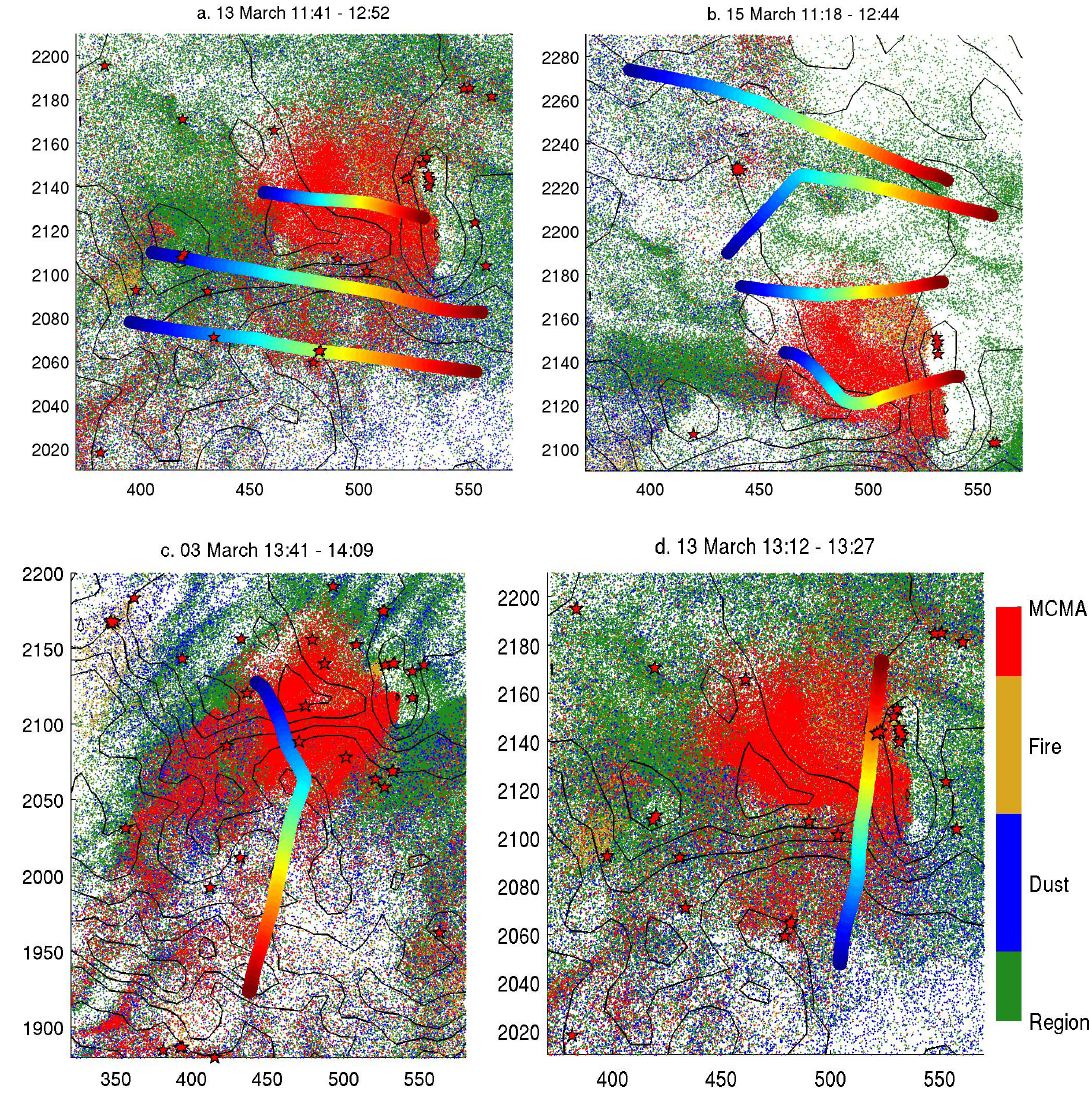
Fig. 7. Flexpart particle clouds colored by emission source using the colorbar in —bf(d). The path of the HSRL curtain plots is shown by the colored line. The corresponding profile can be found by matching the color along the flight path with the colorbar across the top of the curtain plots. (a) corresponds to Fig. 8, (b) to Fig. 9, (c) to 10 and (d) to Fig. 11. Stars indicate burning fires. Axes show Universal Transverse Mercator zone 14 coordinates in kilometers. Terrain contours shown every